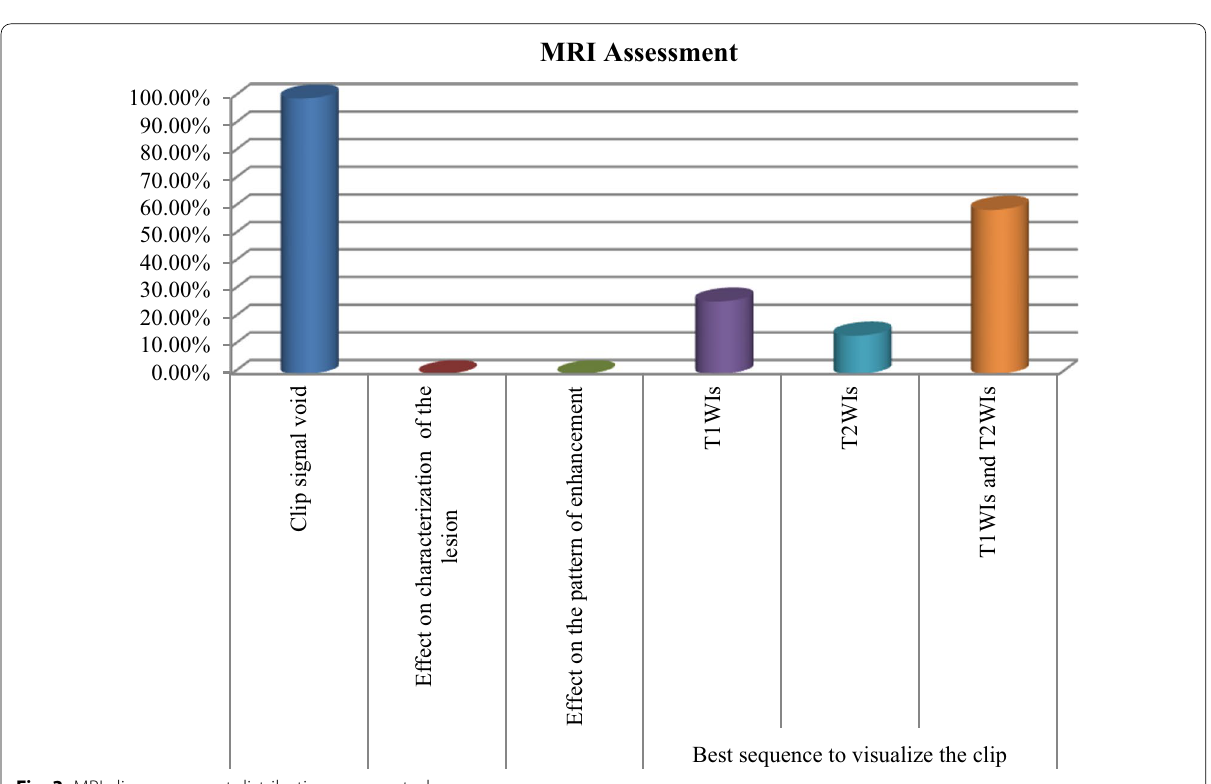
Fig. 3 MRI clip assessment distribution among study